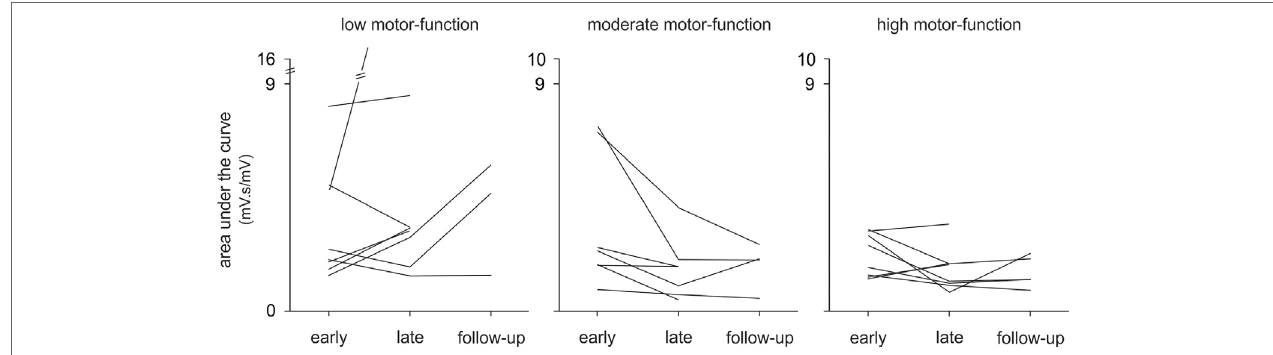
Figure 5 | Changes in electromyography over time, individual patient data. The mean area under the curve is shown for each patient ( n = 24) with low, moderate, and high motor-function levels at early and late therapy and for a subset of patients ( n = 13) at 6-month follow-up during Wii-golf